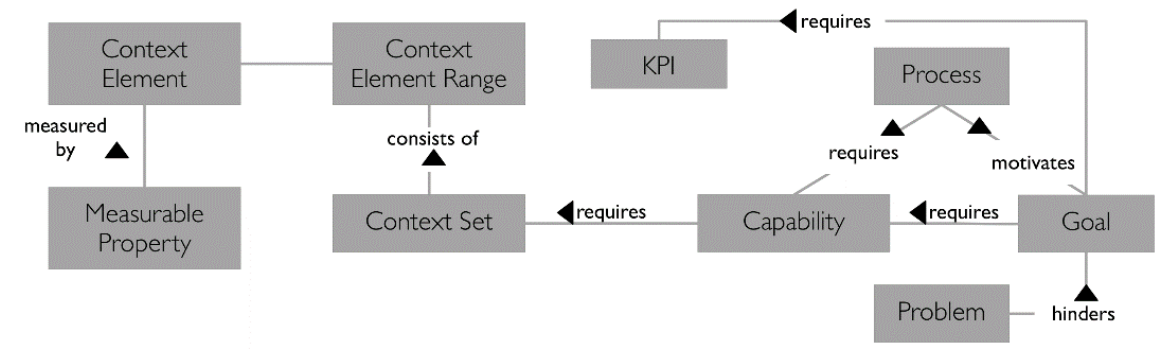
Figure 5. LightCDD meta-model Table 1. Important Concepts and their